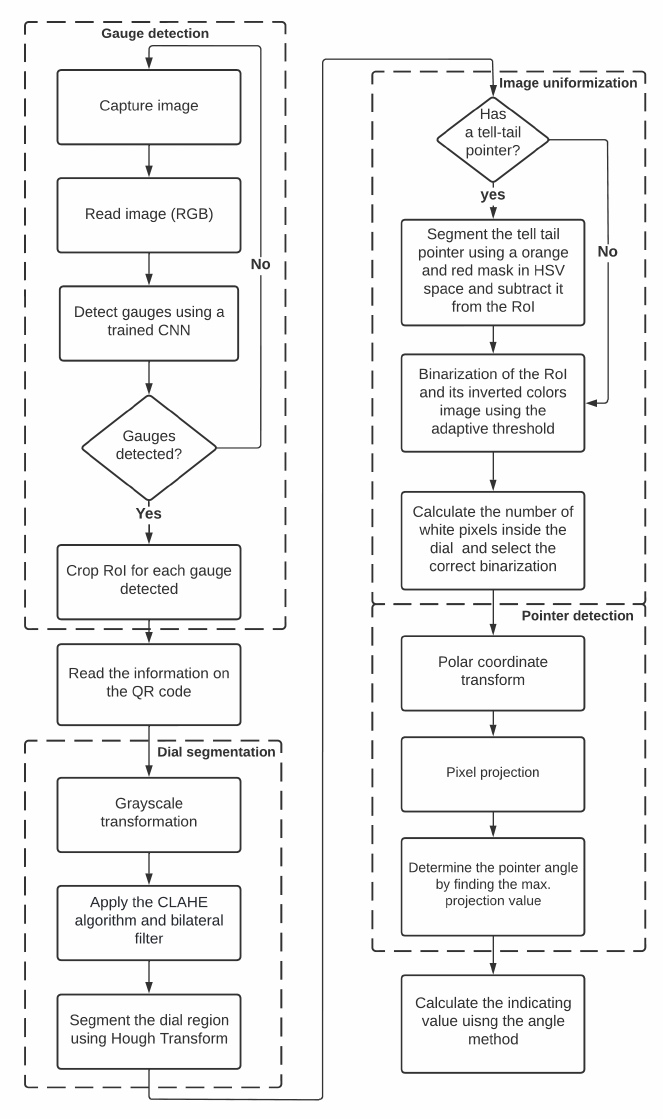
Figure 15. Proposed solution for automatic gauge